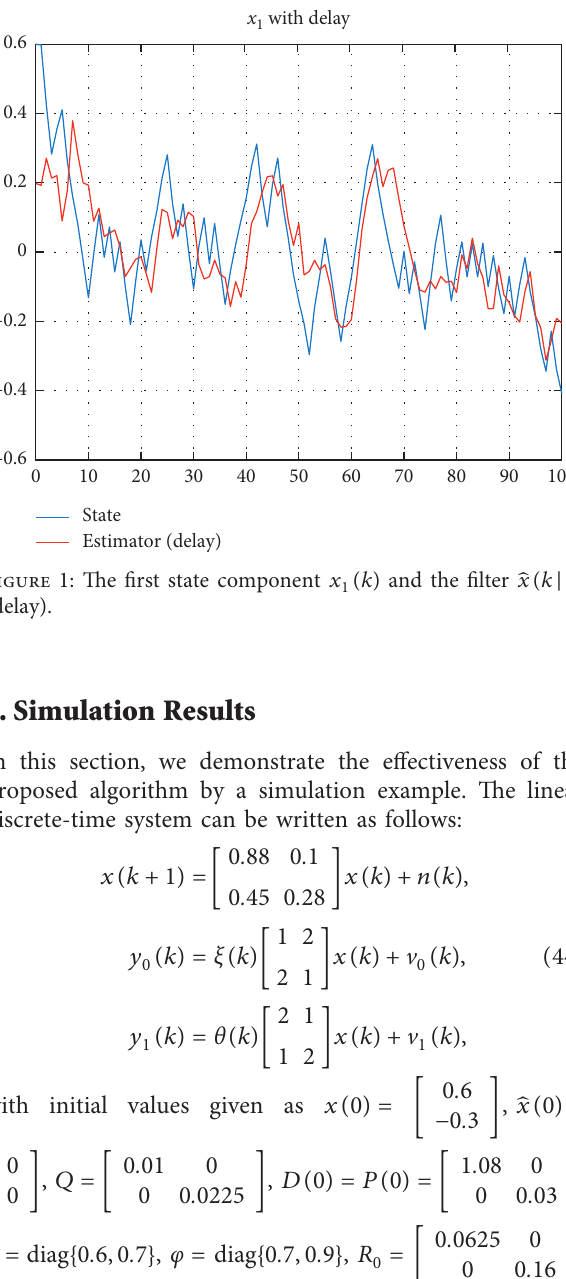
( k ) and the filter 􏽢 x ( k | k ) (no 1